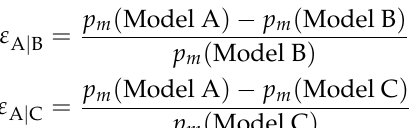
/ ( 2 π ) = 300 Hz to ω ν m